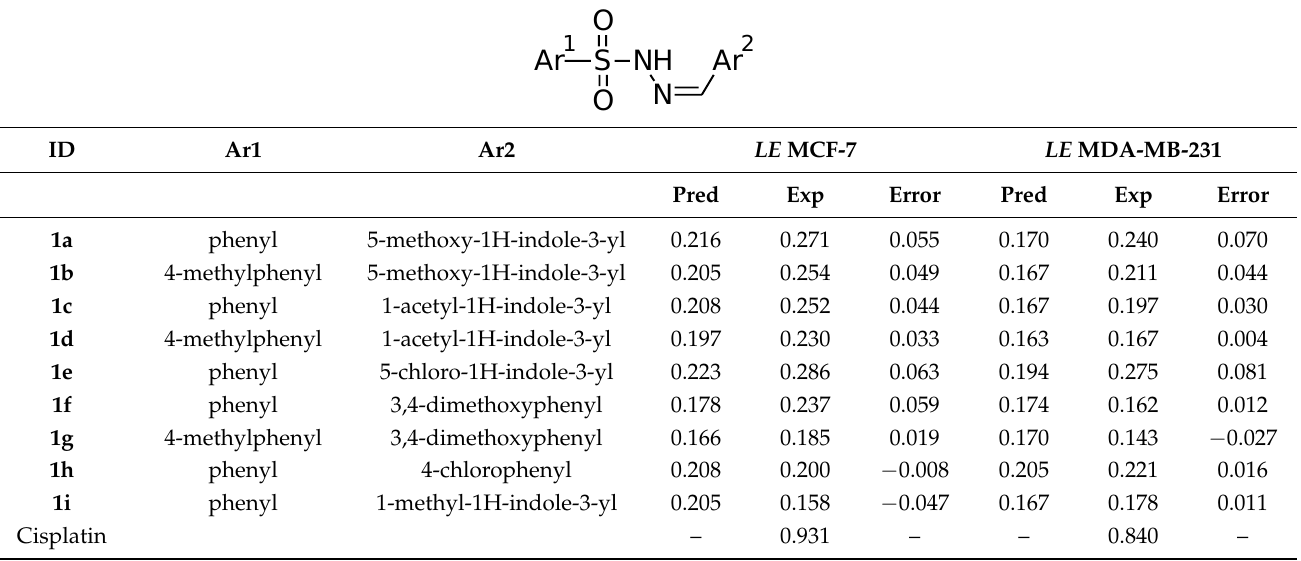
Table 2. Newly designed arylsulfonylhydrazones. The LE values for MCF-7 and MDA-MB-468 cell lines are predicted by the QSAR models derived in the study. The experimental LE values are obtained in vitro by MTT tests.